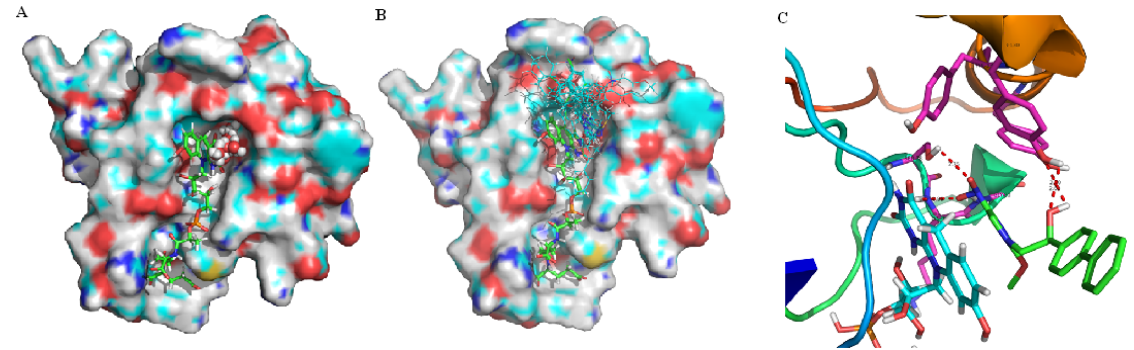
Figure 1. Predicted active site and docked pose for the DDN (PDB 3R5R) of Mtb; ( A ) Predicted active site between DDN and flavine ring of F420, green; F420, sphere; binding site; ( B ) Binding conformations of 21 docked compounds at the active site; ( C ) The interactions between the active binding site and compound 15